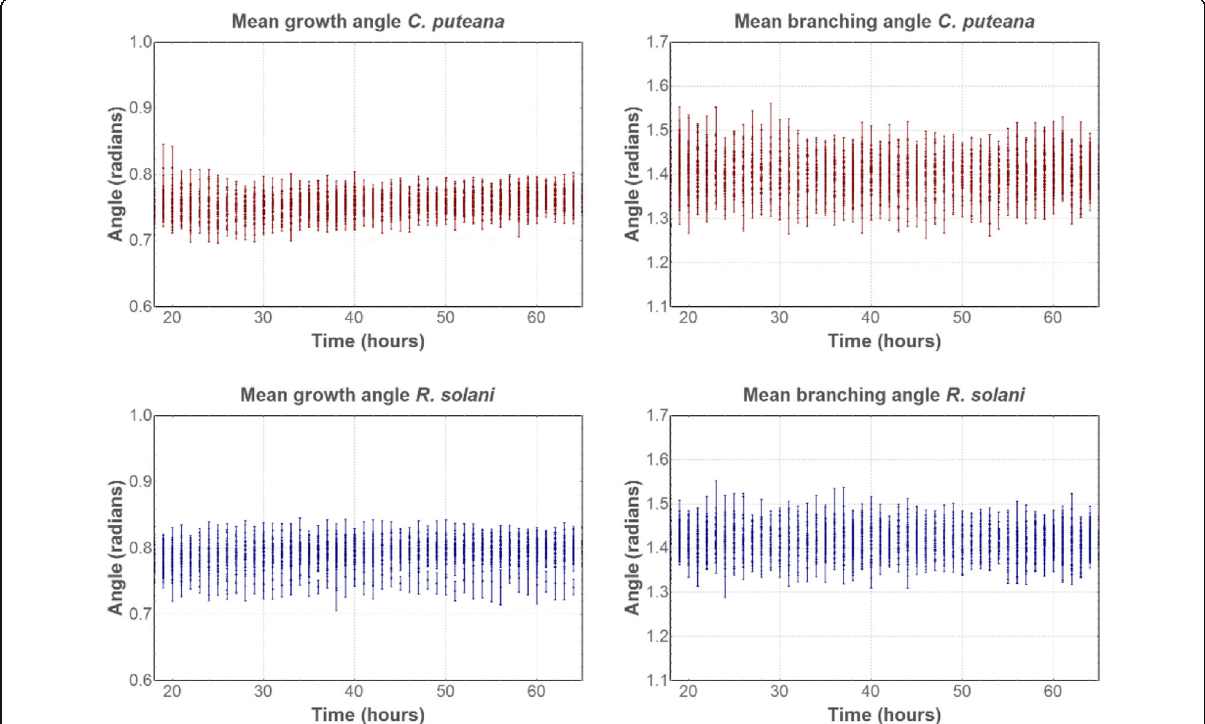
Fig. 4 Mean growth and branching angles of C. puteana (red) and R. solani (blue), for four replicates of 16 conditions. The mean growth and branching angles at a given time were calculated by taking the mean of all growth and branching angles present in the mycelium at that